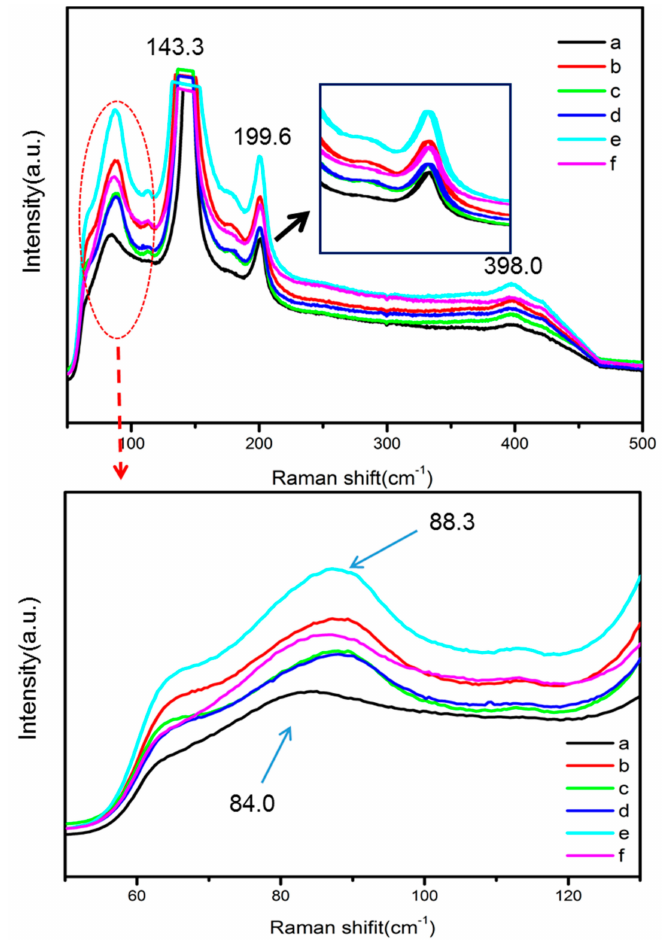
Figure 2. The Raman spectra of ( a ) BiClO; ( b ) BiDy 0.5 ClO; ( c ) Bi0Dy 1.0 ClO; ( d ) BiDy 1.5 ClO; ( e ) BiDy 2.0 ClO; and ( f ) BiDy 2.5